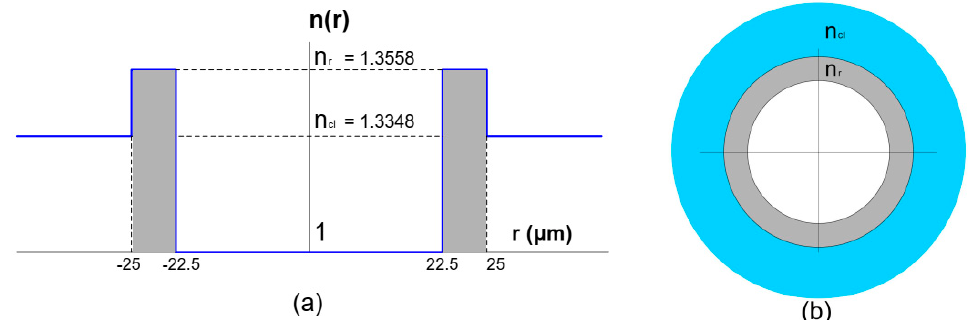
Figure 2. ( a ) Index profile of the proposed vortex polymer optical fiber (POF) by adopting an air-core design. n r is the refractive index of the ring and n cl is the cladding refractive index. ( b ) Cross-section of the designed fiber.